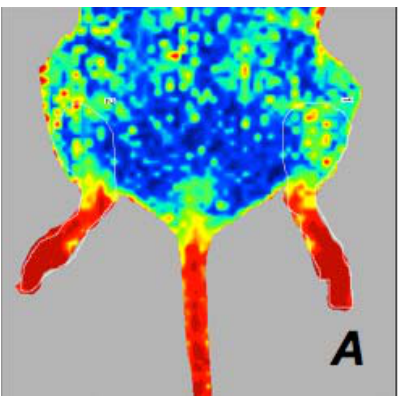
Figure 4. Laser Doppler images of the hind limbs of mice. Perfusion signal is associated with the type of anaesthesia when the mouse is placed in dorsal recumbency. These mice have a body temperature of 36 °C (A , B , C , D) . Intraperitoneally anaesthetised mice (A,B) show higher perfusion values than those of the isoflurane-anaesthetised mice (C,D), in comparison to ARC mice (A,C) or ARD mice